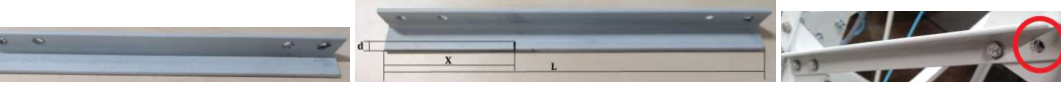
Figure 3. Different structural state scenarios studied in this work. Replica (healthy) bar ( left ). Crack damage, where L is the length of the bar, d = 5 mm is the crack size, and X = L /3 is the location of the crack in the bar ( center ). Missing bolt ( right